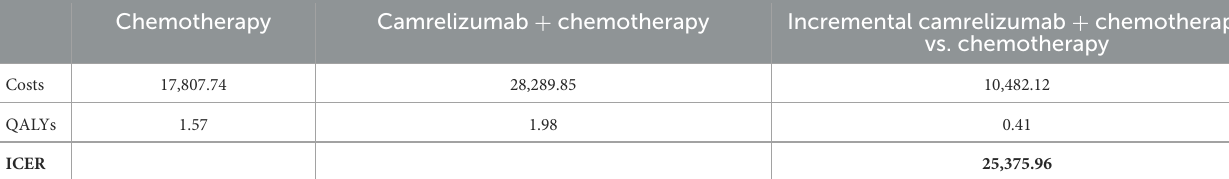
TABLE 4 Cost-effectiveness of treatment of camrelizumab + chemotherapy vs. chemotherapy in full trial